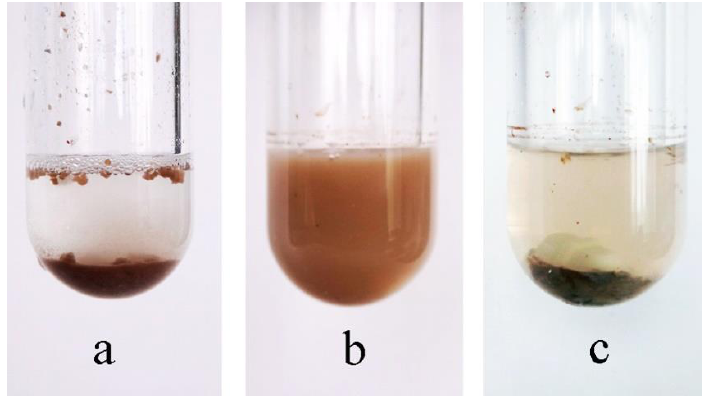
Figure 10. Different stages of epoxidation: ( a ) Before reaction; ( b ) during the reaction; ( c ) after the reaction.